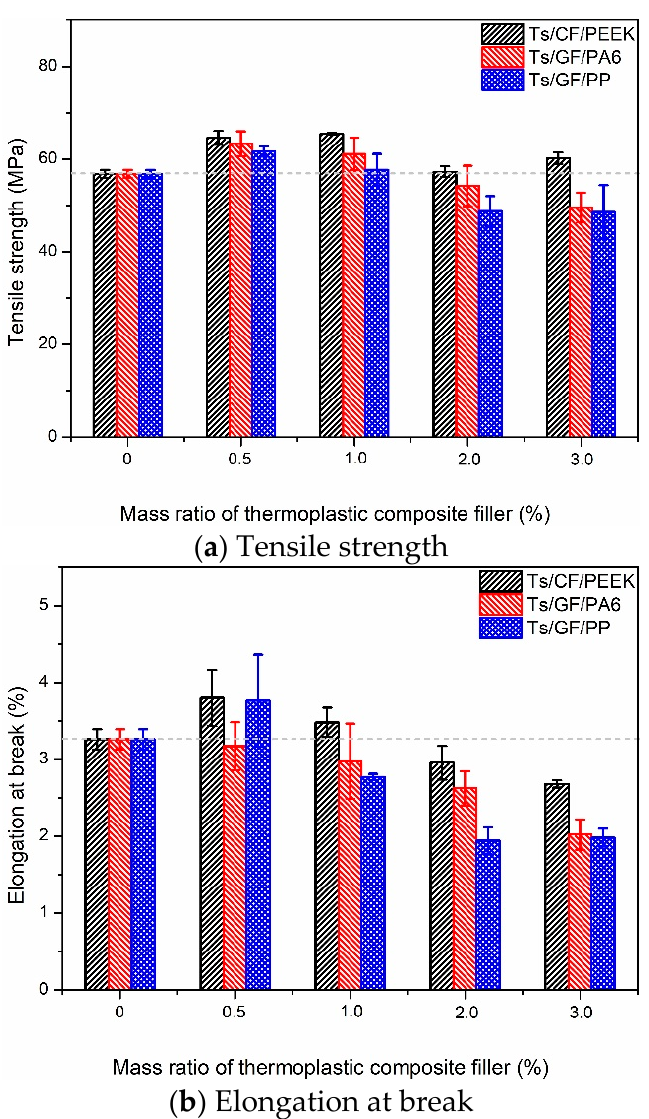
Figure 4. Effects of thermoplastic composite fillers on the tensile properties of Ts resin of ( a ) tensile strength and ( b ) elongation at break.